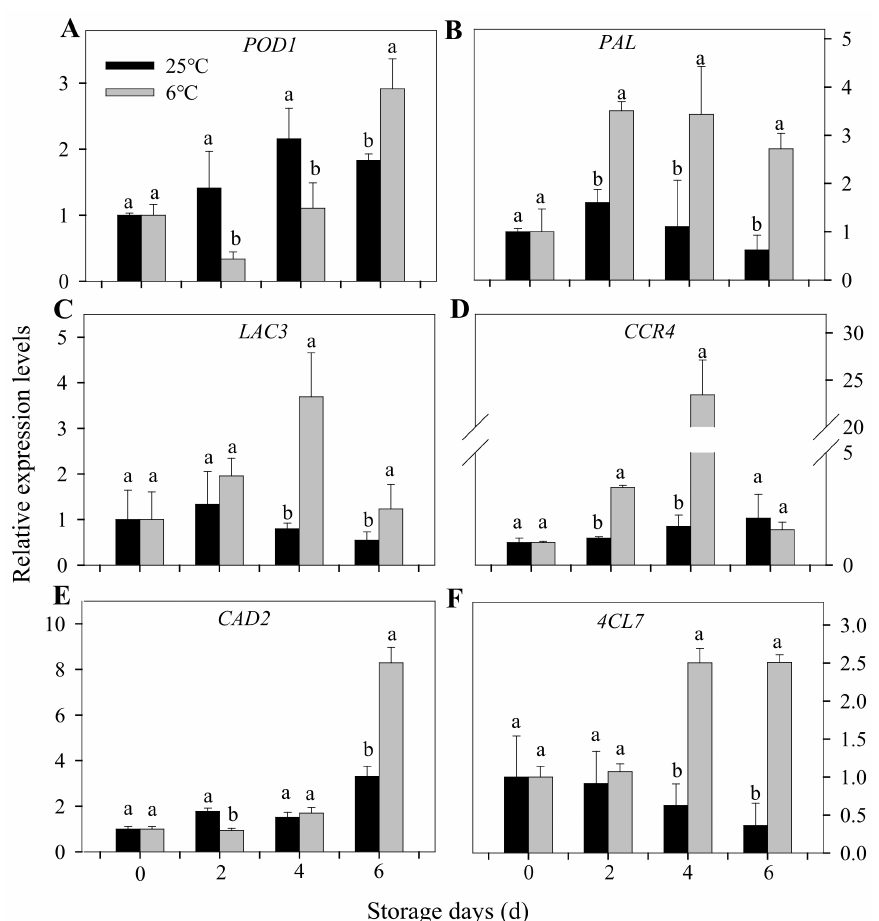
Figure 7. Changes in the relative expression of genes associated with lignification in banana peels during storage at 6 ◦ C and 25 ◦ C. POD1 ( A ), PAL ( B ), LAC3 ( C ), CCR4 ( D ), CAD2 ( E ), and 4CL7 ( F ). Each data point represents a mean ± standard error ( n = 3). The values with different letters for different storage temperature for each sampling date are significantly different ( p <